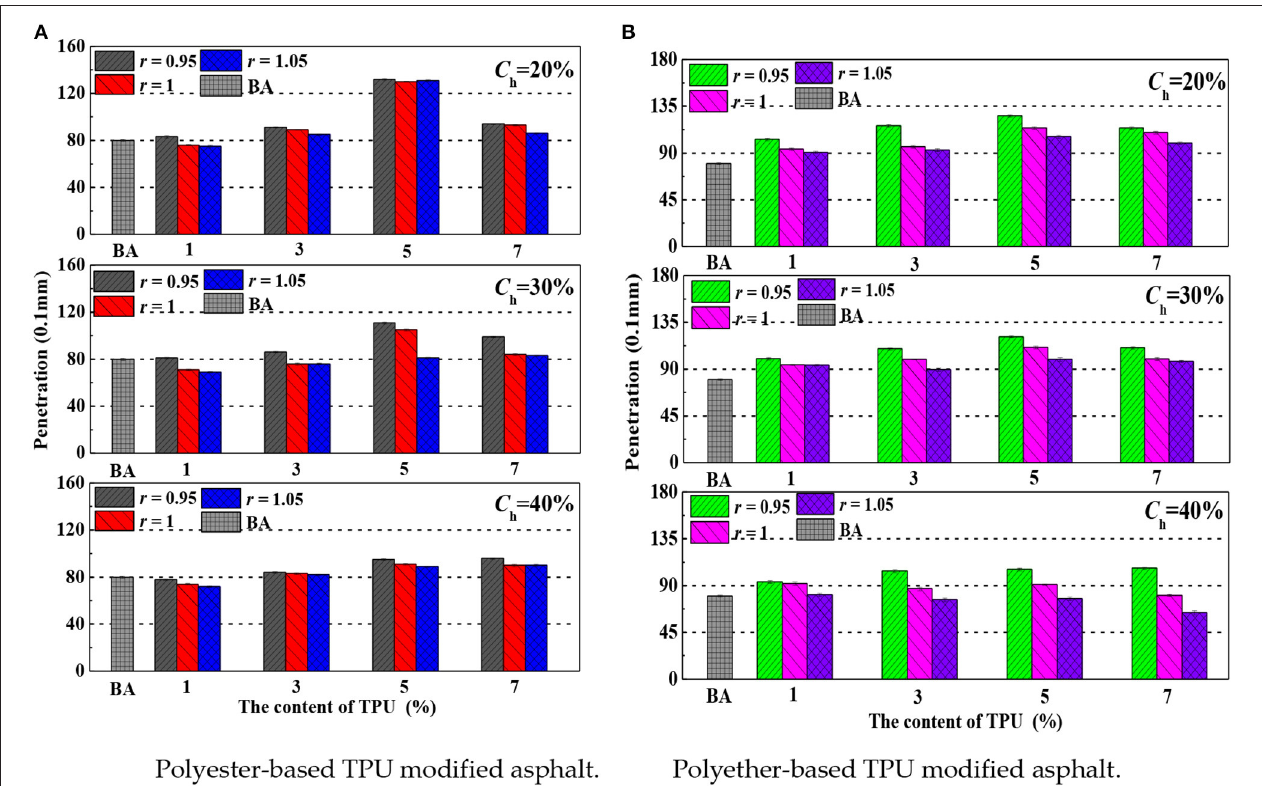
FIGURE 9 | The penetration of modified asphalt. (A) Polyester-based TPU-modified asphalt. (B) Polyether-based TPU-modified asphalt.